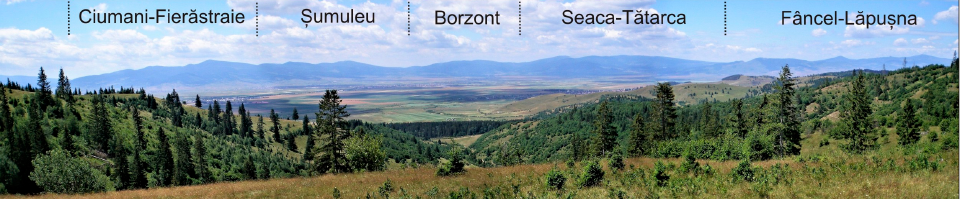
Figure 8. Panoramic view of the Gurghiu Mountains, as seen from the East (Jolotca village) across the Gheorgheni Quaternary intra-mountain basin. The volcanic edifices (from left to right, from South to North, respectively): Ciumani-Fier ă straie, Ș umuleu, Borzont, Seaca-T ă tarca, and Fâncel-L ă pu ș na. Note the shield-like profile of the Borzont and Seaca-T ă tarca edifices. (Photo: Alexandru Szakács).